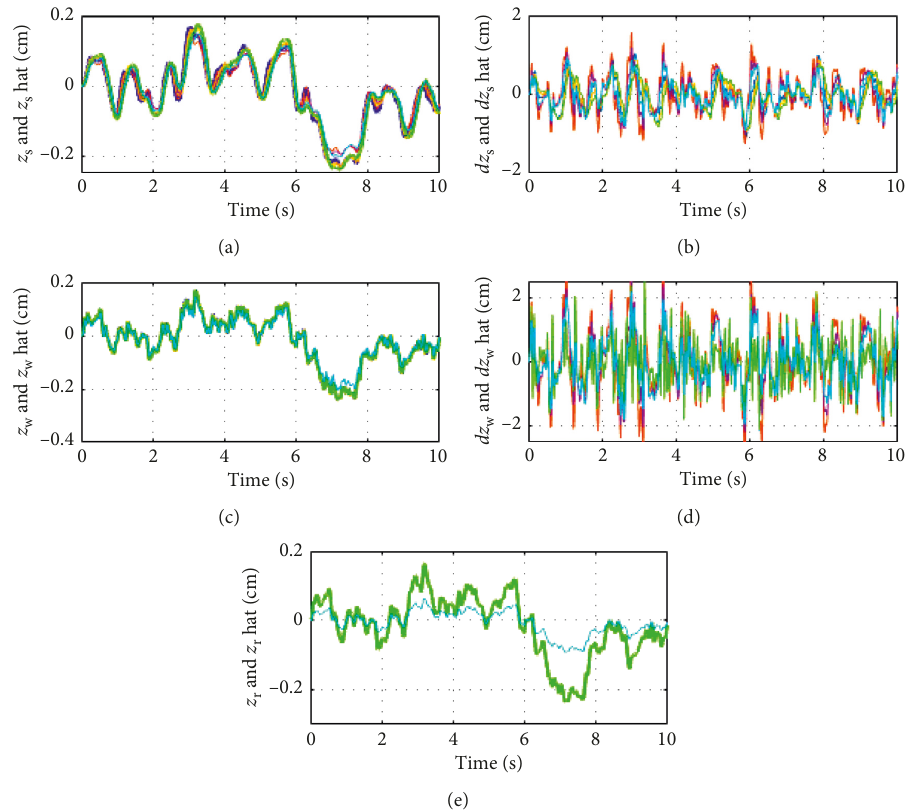
Figure 20: The estimated states for the case of varying the mass of the sprung. Case 1: m states and red solid line for estimated states. Case 2: m s � 124.3kg, orange solid line for suspension system states and purple solid line for estimated states. Case 3: m s � 154.3kg, green solid line for suspension system states and light blue solid line for estimated states. (a) z s and z s hat. (b) dz s / dt and dz s / dt hat. (c) z w and z w hat. (d) dz w / dt and dz w / dt hat. (e) z r and z r